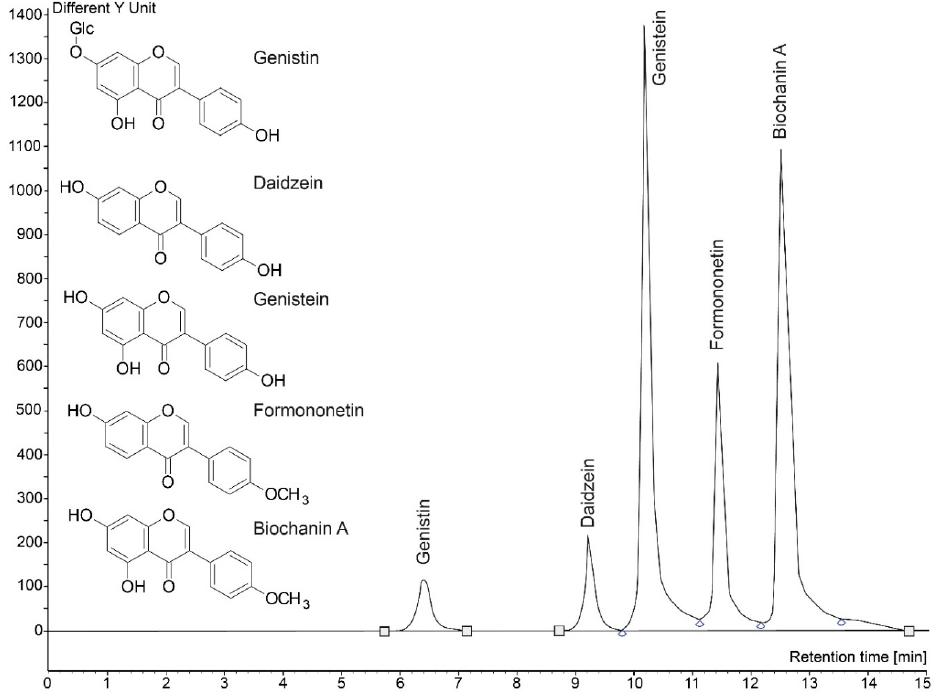
Figure 9. HPLC chromatogram of monitored isoflavones standards and their chemical formula.